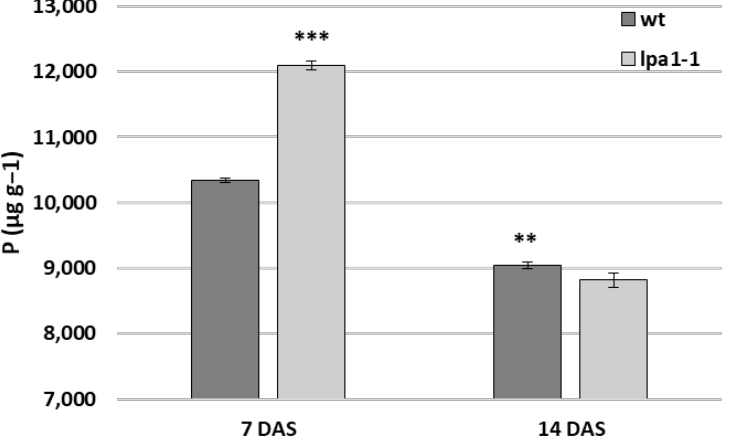
Figure 4. Phosphorus (P) content determined by inductively coupled plasma mass spectrometry (ICP-MS). Analysis performed on maize seedling dry matter of wild-type and lpa1-1 mutant at 7 and 14 DAS. P content was expressed as micrograms per gram of dry matter. Values represent the mean of three biological replicates. Significant differences between wild-type and lpa1-1 were assessed by Student’s t -test (** p < 0.05 and *** p < 0.01). Table 1. Mineral nutrient and trace element content determined by inductively coupled plasma mass spectrometry (ICP-MS). Analyses were performed on maize seedling dry matter of wild-type and lpa1-1 mutant at 7 and 14 DAS. The elements were expressed as micrograms per gram of dry matter. SD is shown ( n =3, p < 0.05). 7 DAS 14